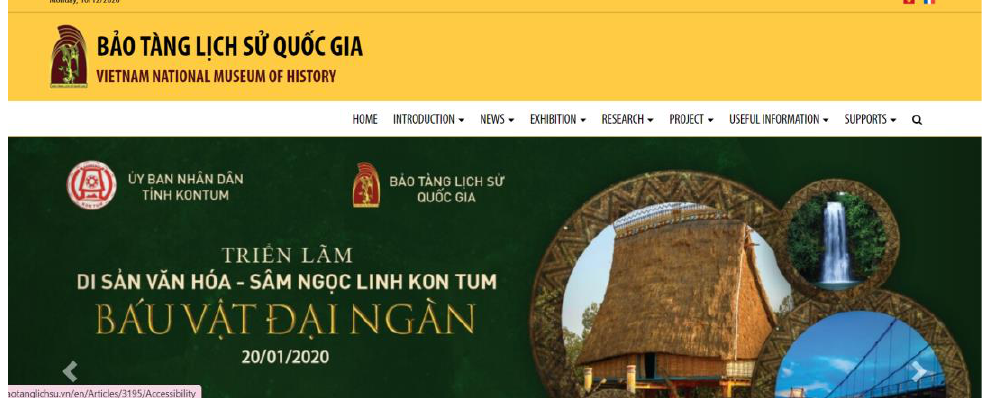
Figure 3. Screenshot of homepage’s websites of VNMH.